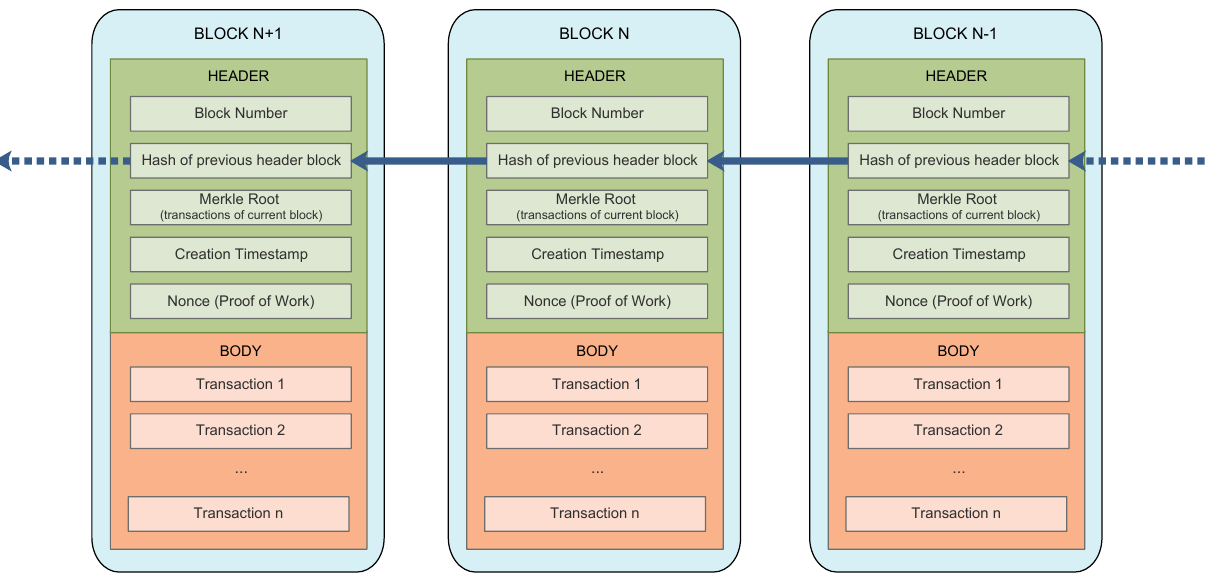
Figure 6. Structure of the blocks in the